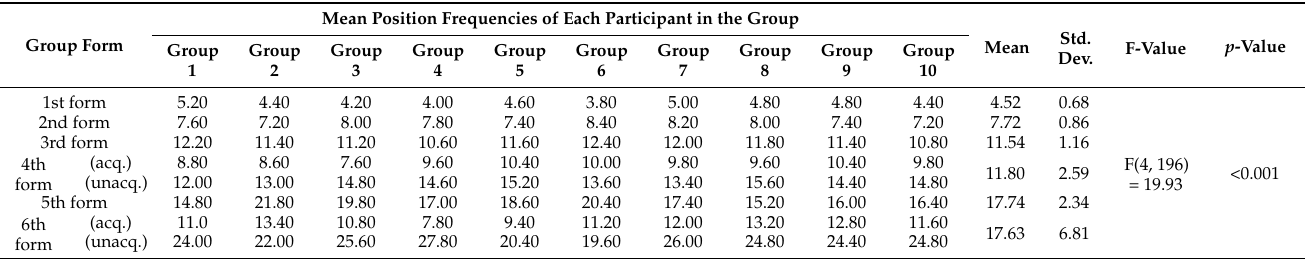
Table 4. Participants’ position change frequency difference across 6 group